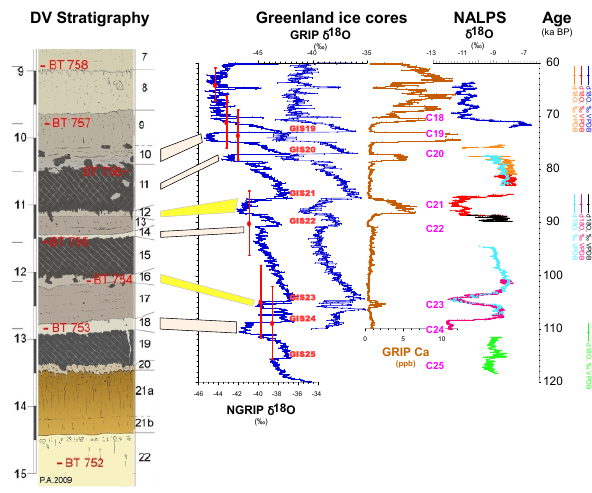
Fig. 7. Correlation between DV soil complexes and several well- dated isotopic records. The latter are shown, from left to right, as the three Greenland records of NGRIP δ 18 O (Andersen et al., 2004), GRIP δ 18 O and the GRIP dust record (Johnsen et al., 2001); and the δ 18 O from NALPS speleothems (Boch et al., 2011). Indication of Greenland interstadials (Rousseau et al., 2006b) and of North Atlantic cold events from (McManus et al.,